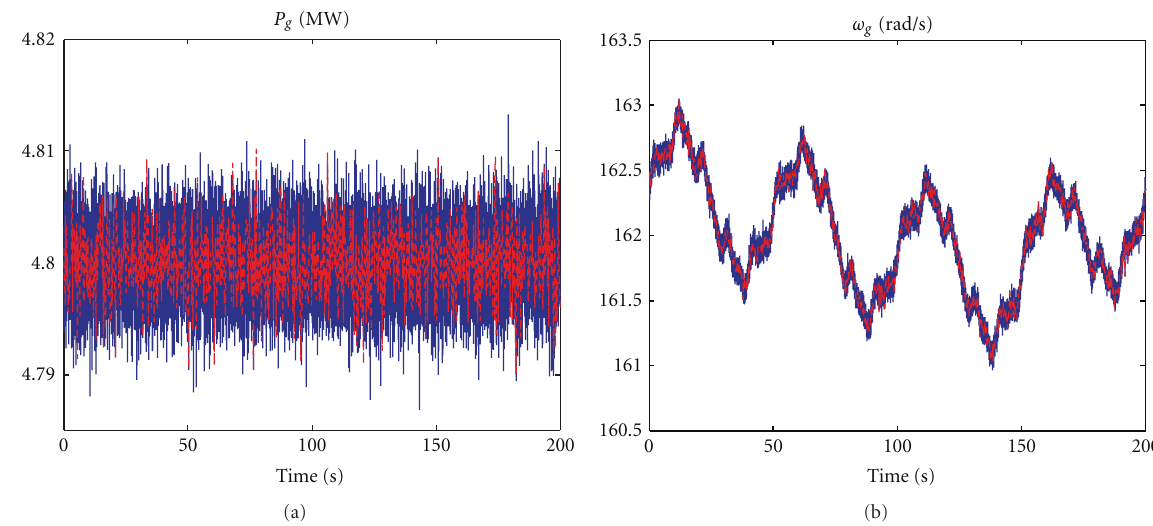
Figure 2: TS fuzzy model estimated outputs (red) compared with the measured ones (blue).